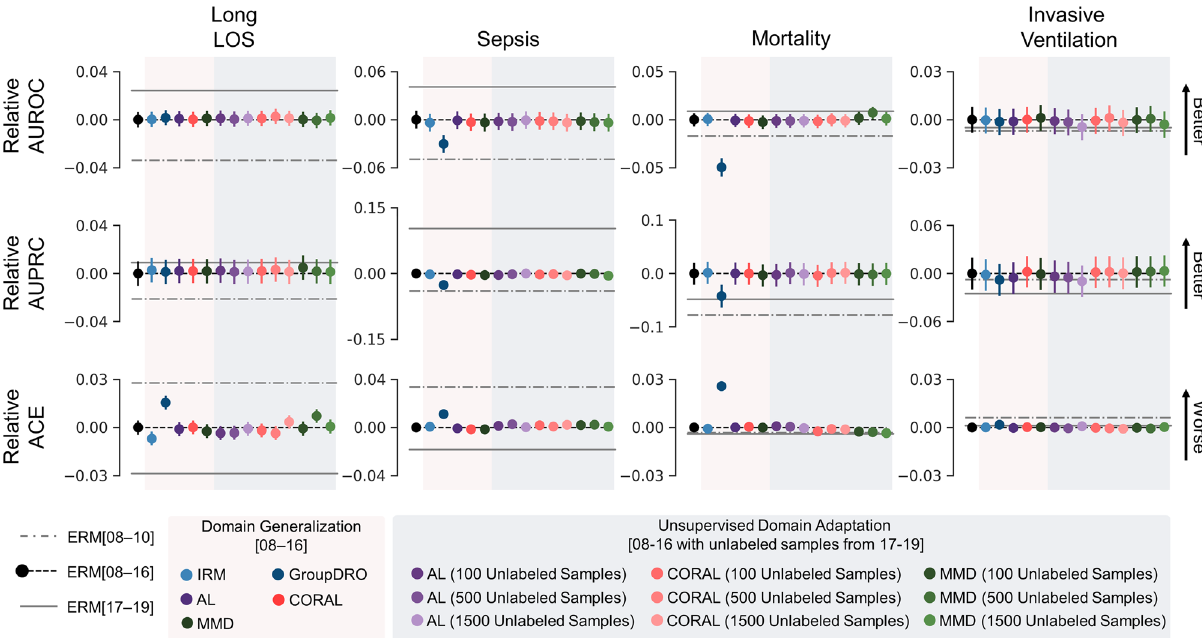
Figure 3. Difference in mean performance of DG and UDA approaches relative to ERM[8–16] in the target year group (2017–2019). Performance of ERM[8–10] (train set 2008–2010 and test set 2017–2019, dashed line) and ERM[17–19] (train and test sets 2017–2019, solid line) models are also shown for comparison. Error bars indicate 95% confidence interval obtained from 10,000 bootstrap iterations. Here, we show results from three of the four experimental conditions using differing number of unlabelled samples for UDA—we did not observe meaningful differences across the number of unlabelled samples evaluated. Numerical representation of the performance measures relative to ERM[8–16] are presented in Supplementary Table S3. LOS: length of stay; ERM: empirical risk minimization; IRM: invariant risk minimization; AL: adversarial learning; GroupDRO: group distributionally robust optimization; CORAL: correlation alignment; MMD: maximum mean discrepancy; AUROC: area under the receiver operating characteristics curve; AUPRC: area under the precision recall curve; ACE: absolute calibration error; domain generalization: DG; unsupervised domain adaptation: